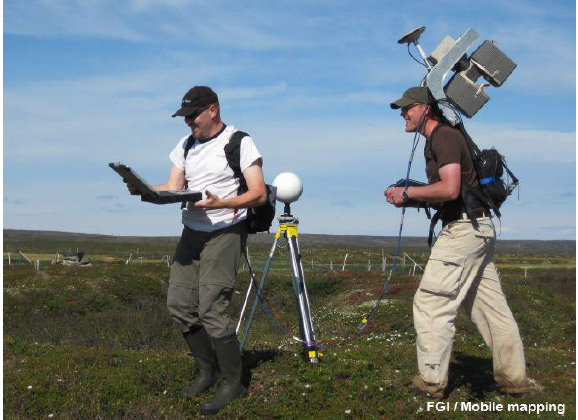
Figure 10. Mapping of permafrost palsa landforms in Finnish Lapland with the Akhka backpack mobile laser scanning